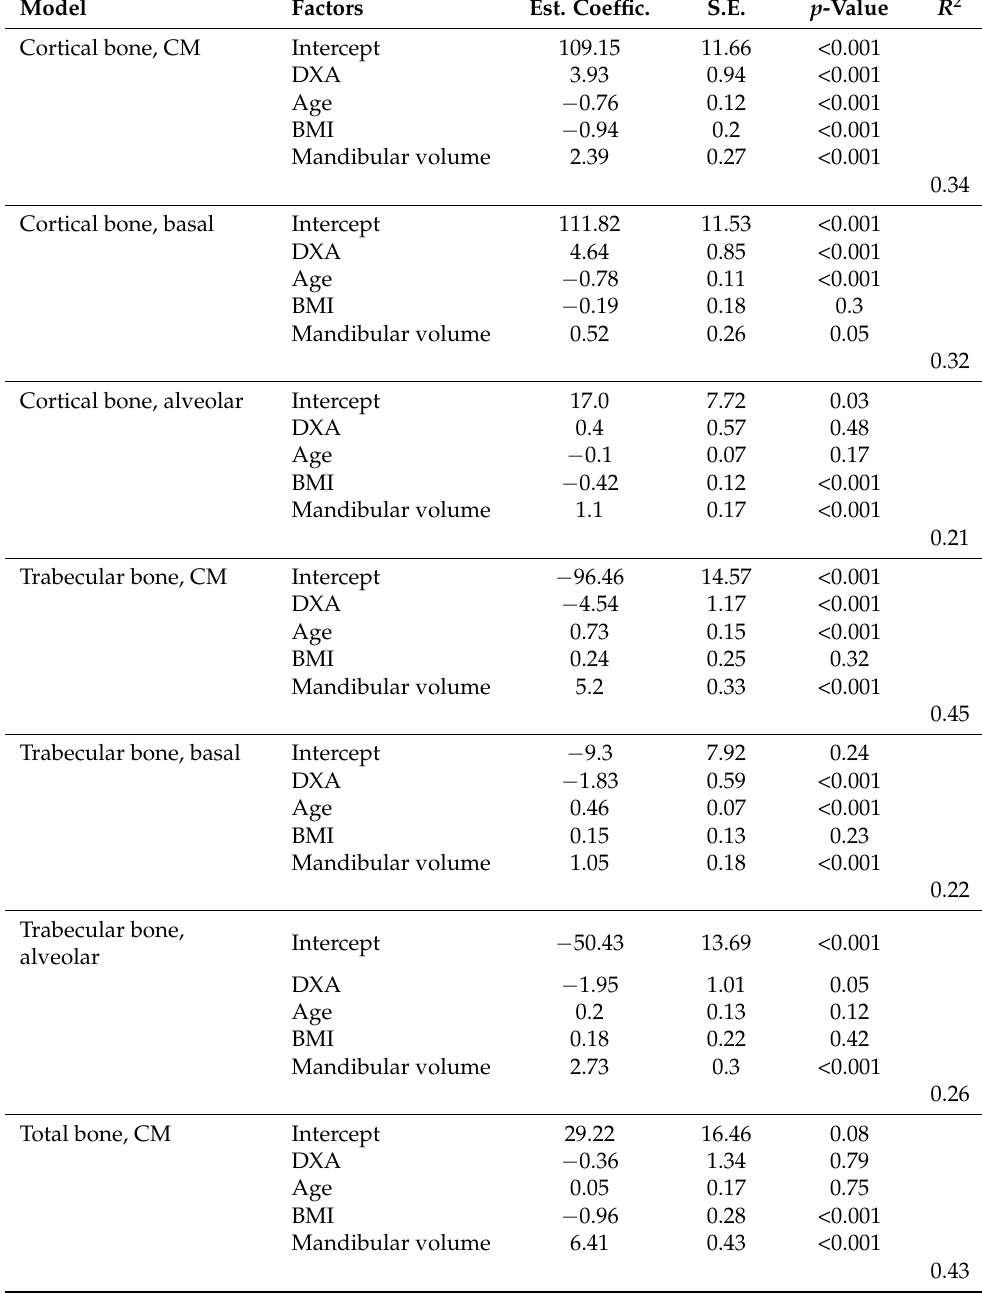
Table 3. Linear regression analysis to detect connections among the cortical, trabecular, and total bone volume in the complete mandibular area and the basal part of the mandibular body with the worst DXA T-scores after excluding